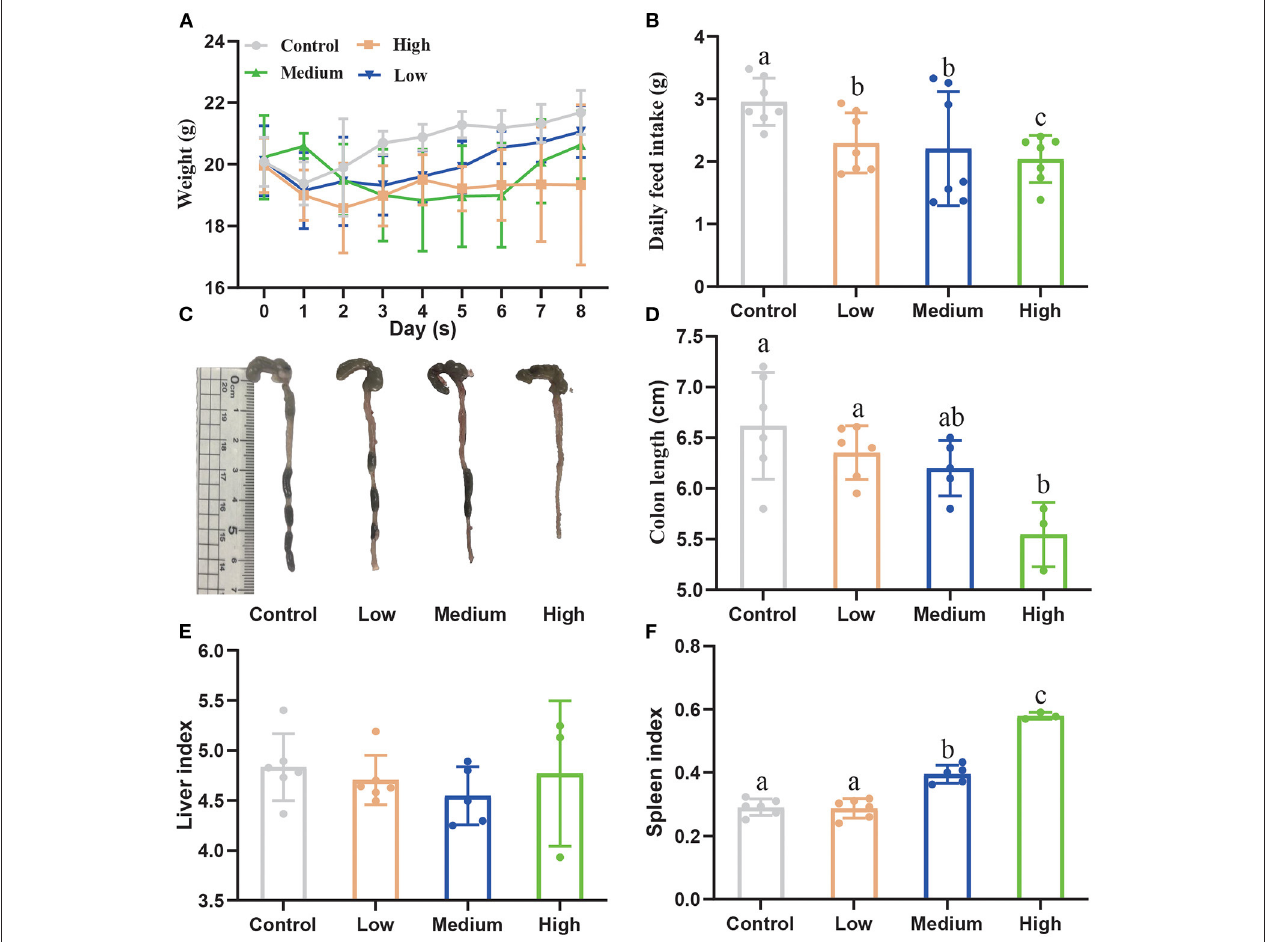
FIGURE 3 | The effect of Clostridium perfringens administration on the growth performance of mice. (A) Bodyweight (BW) was recorded every day. (B) Daily feed intake was recorded among four groups. (C) The colon images among four groups. (D) The colon length was measured among four groups. (E) The liver index. (F) The spleen index. a , b , c Means values with dissimilar letters were significantly different ( P < 0.05). The calculation formula of liver index: liver weight/body weight × 100%. The calculation formula of spleen index: spleen weight/body weight × 100%.